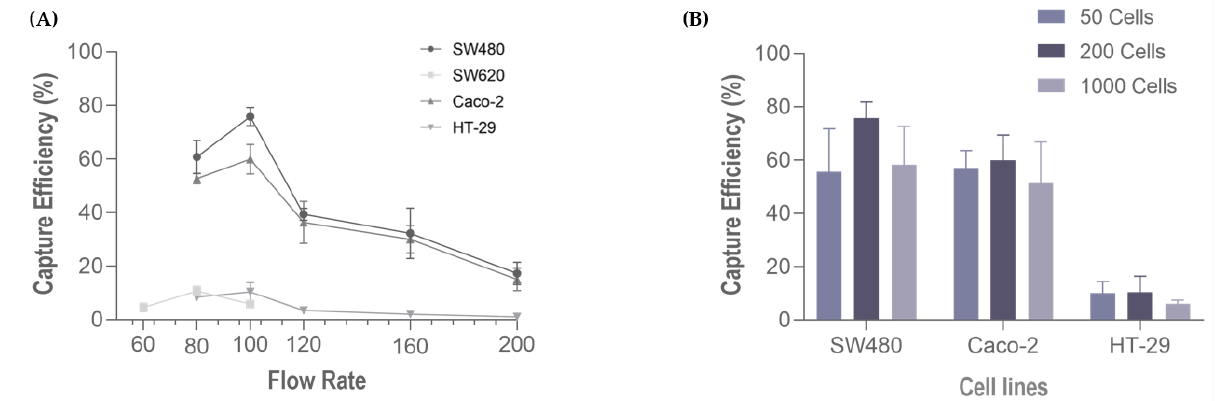
Figure 5. Capture efficiency of the RUBYchip™ ( A ) at six flow rates, using four different CRC cell lines (SW680, Caco 2, SW620 and HT-29), and ( B ) varying the number of spiked cells (50, 200 or 1000) at 100 µL/min, with three different cell lines, SW480, Caco 2.